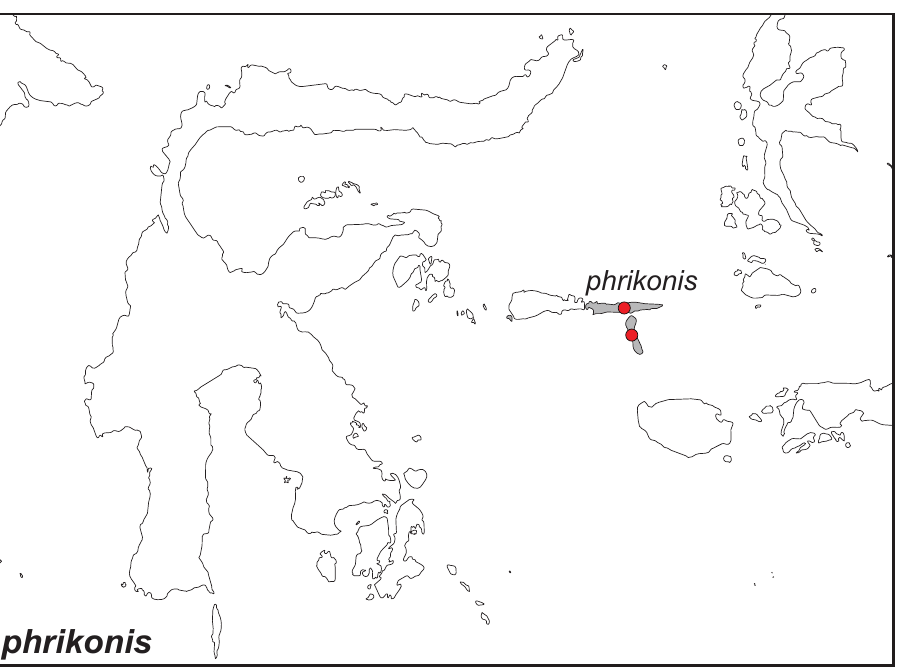
Figure 74. Distribution map of Elymnias phrikonis